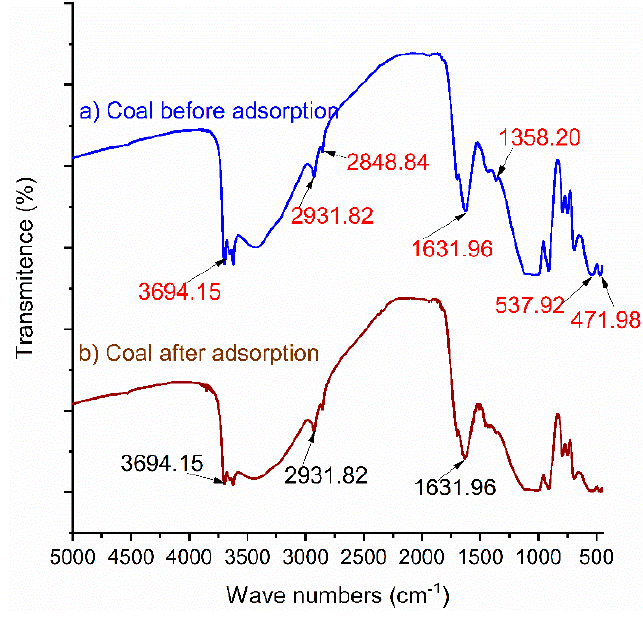
Figure 1. FT-IR results for leftover coal material ( a ) before and ( b ) after adsorption. X-ray diffraction (XRD) analysis was performed to observe the crystal structure and mineral composition of the adsorbents. The XRD patterns of the leftover coal were recorded using an XRD apparatus (XRD-7000, SHIMADZU Corporation, Japan). Before XRD analysis, the leftover coal material was washed, dried in an oven to the appropriate temperature, and milled and sifted through a 75-micrometer sieve to obtain uniform and homogeneous particles. Then, XRD analysis was recorded with CuK α as the source radiation at wave length of 1.4 nm, at 40 kV and 30 mA (Figure 2). All employed chemicals and reagents in this study were of analytical grade unless otherwise specified.